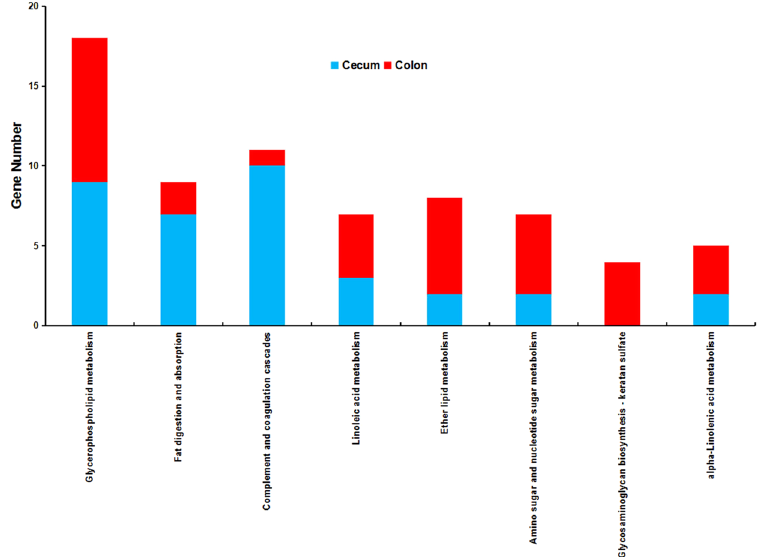
Figure 5. KEGG pathways achieved significant enrichment between the cecum and colon at both the FPKM ≥ 1 and FPKM ≥ 10 level. Cecum: Cecum higher expressed genes; Colon: Colon higher expressed genes.